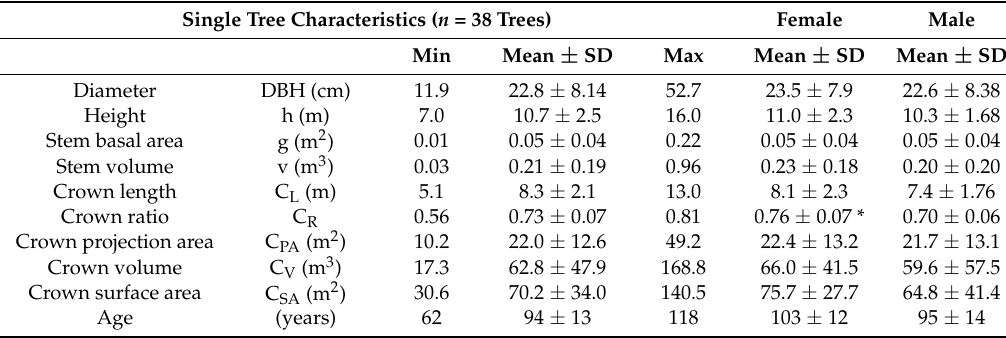
Table 1. Description of the sampled European yew